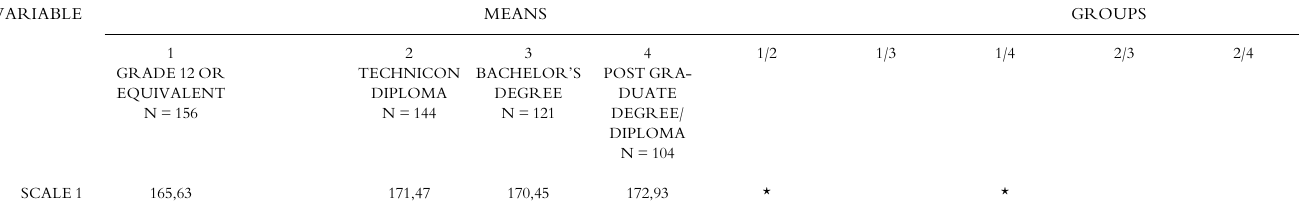
TABLE10 DUNNETT’S POST-HOCMULTIPLECOMPARISONS: COMPARISONOF THE MEANSOF THEVARIOUS‘‘ACADEMICGROUPS’’IN RESPECTOF SCALE1OF THELSPQ MEANS